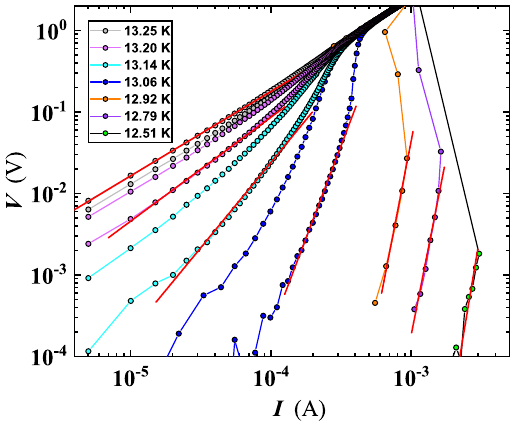
Figure 7. Voltage − current characteristics for the film MO10. Experimental data of the sweep-up curve were fitted by a power law function to extract the value of α (see Equations (4) and (5) and Table